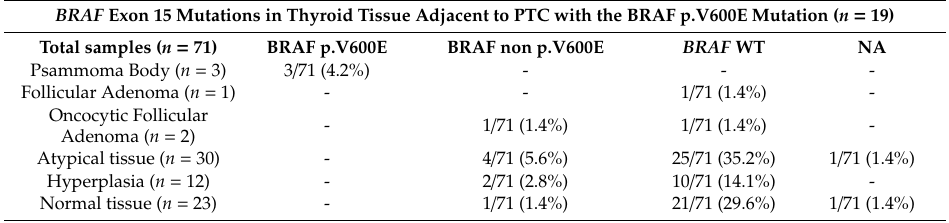
Table 4. BRAF exon 15 mutations in thyroid tissue adjacent to PTC.